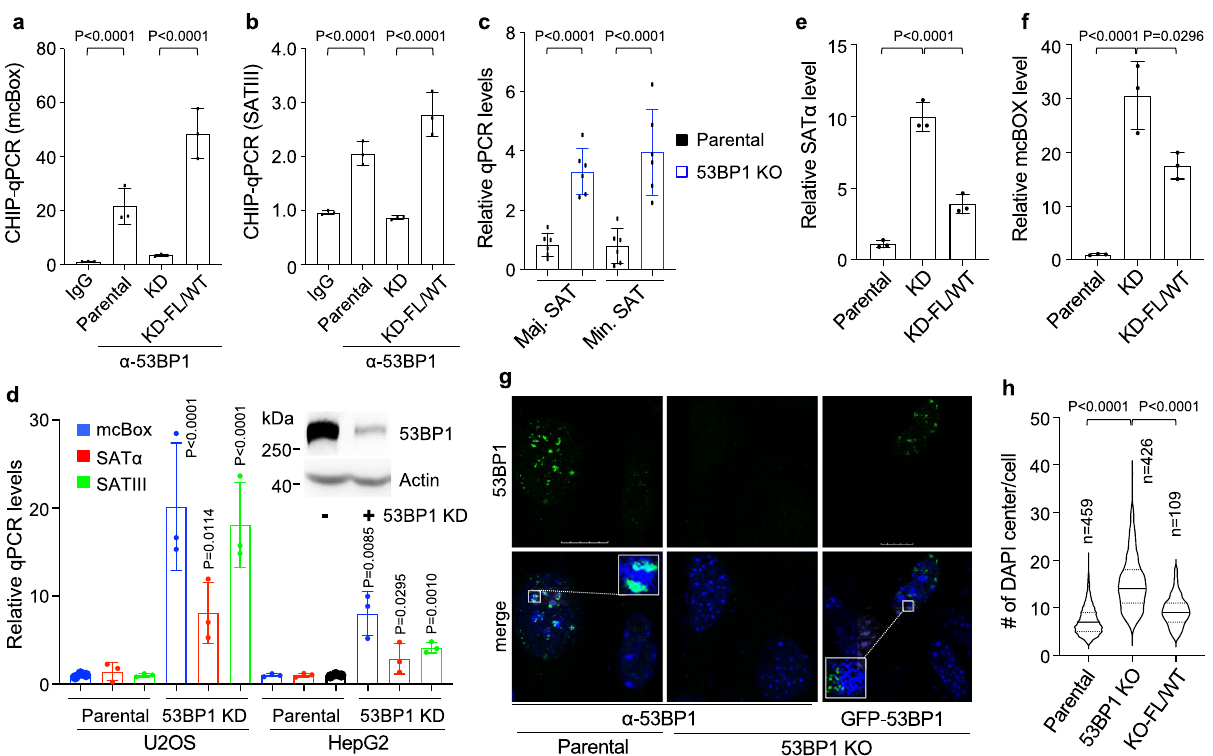
Fig. 4 53BP1 maintains the repressive state of heterochromatin. ChIP-qPCR of 53BP1 at alpha satellite repeats of mcBox ( a ) and SATIII ( b ) regions in HEK293T parental, 53BP1 KD and KD reconstituted with GFP-53BP1-FL/WT cells from n = 3 biological replicates. c Transcript levels of Maj and Min SATs measured by qPCR in parental and 53bp1 KO MEFs from n = 6 biological replicates collected from two independent experiments. d Transcript levels of alpha satellite repeats of heterochromatin from parental and stable 53BP1 KD U-2 OS or HepG2 cells from n = 3 biological replicates. Inset: representative protein expression in U-2 OS cells from two independent experiments. Transcript levels of the alpha satellite repeat SAT α ( e ) and mcBOX ( f ) from HEK293T parental, 53BP1 KD and KD cells reconstituted with GFP-53BP1-FL/WT from n = 3 biological replicates. g Representative single z-plane confocal images of parental, 53bp1 KO and KO MEFs reconstituted with GFL-53BP1-FL/WT. Squares: enlarged areas. Scale bar is 10 μ m. h Violin plot of the number of heterochromatin centers visualized by DAPI from indicated number of cells from at least three independent experiments. Data represent mean, 25th, and 75th percentiles with the whiskers extending to the minimum and maximum values. Data represent mean values and SD in ( a – f ). Statistical analyses in ( d ) were compared with parental cells. Unpaired two-tailed t test was done by Prism 9.0 with 95% con fi dence intervals in ( a – f ) and ( h